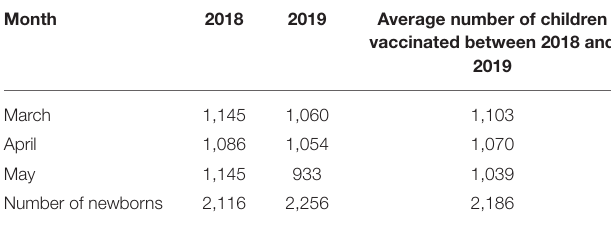
TABLE 2 | Number children vaccinated during 2018 and